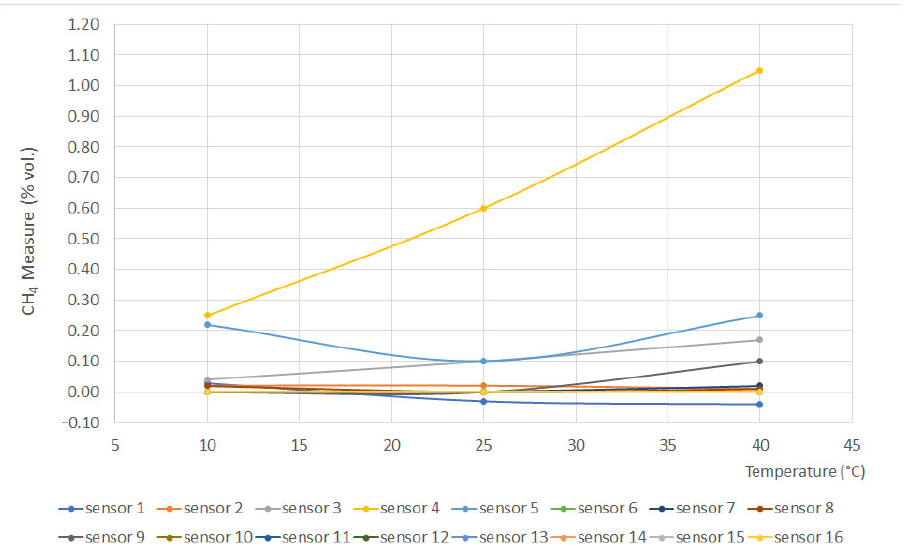
Figure 4. Temperature curves for 0% vol. (Some measures present the same data, therefore some lines are overlapped).